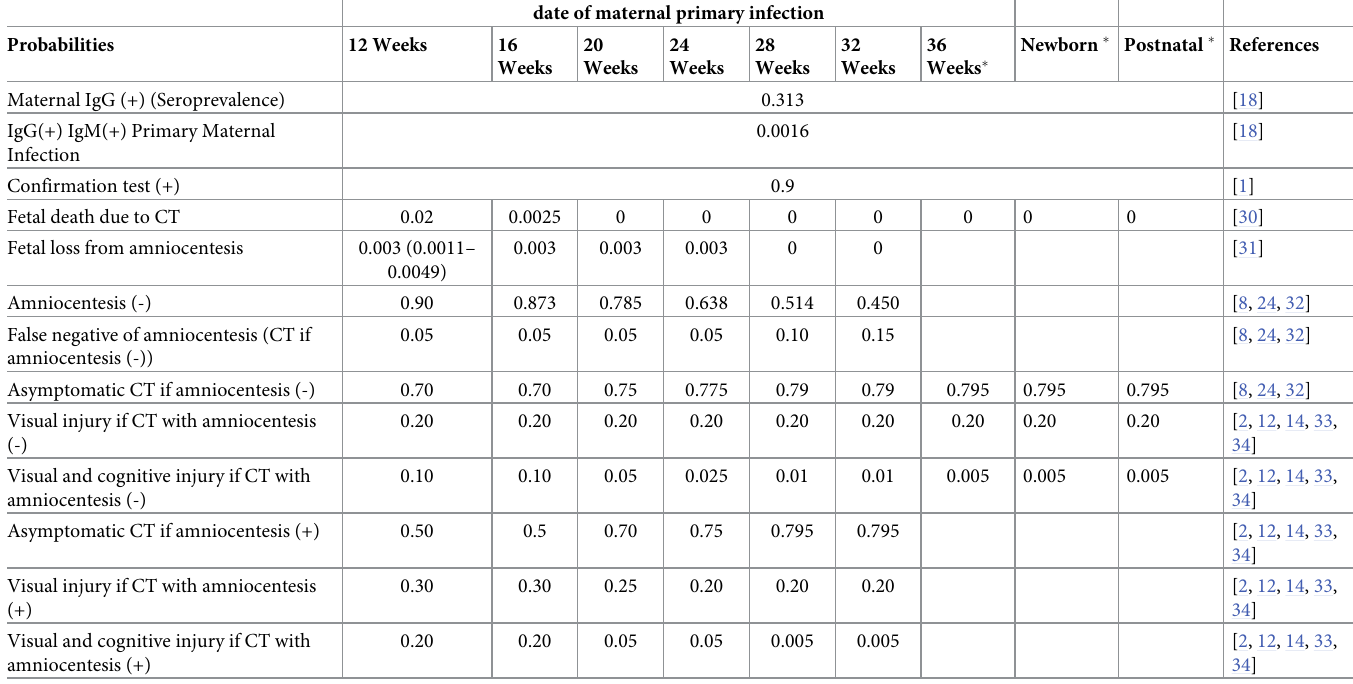
Table 2. Probabilities with screening